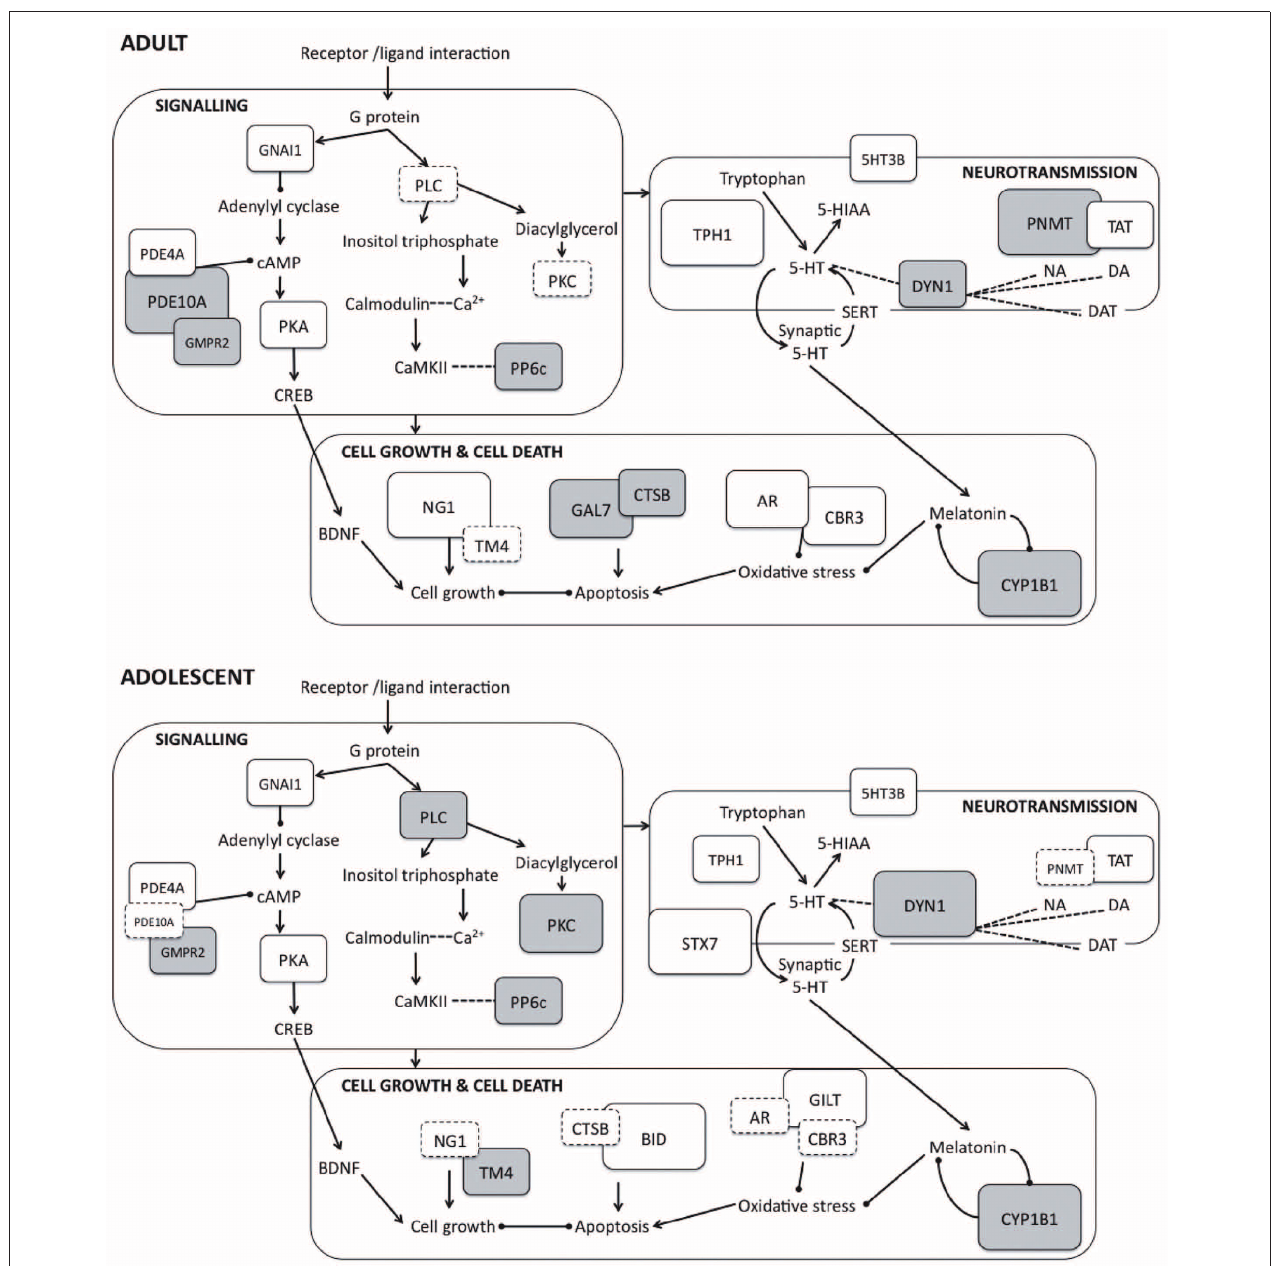
FIGURE 2 | Schematic representation of protein expression changes induced by paroxetine in adult (top panel) and adolescent rats (bottom panel) showing interactions between proteins and their involvement in key cellular activities. Interaction between G protein-coupled receptors and their corresponding ligands leads to activation of downstream signaling pathways. Within these pathways, protein kinases such as PKA, PKC and CaMKII phosphorylate and regulate proteins impacting on cell growth and death, neurotransmission, syntaptic plasticity and receptor function. Arrows represent positive feedback or activation between protein units, while capped lines represent negative feedback or inhibition. The magnitude of the protein expression change induced by is represented by the size and color of the boxes: larger boxes represent larger fold changes, and downregulation is indicated with gray shading. Boxes with dashed outlines represent non-significant protein changes. 5-HIAA, 5-hydroxyindoleacetic acid; 5-HT,